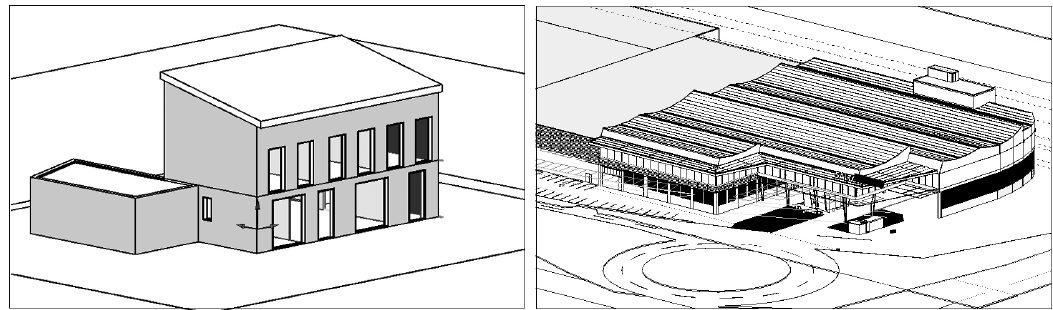
Figure 2. Building information modelling (BIM) models of the residential and warehouse buildings.